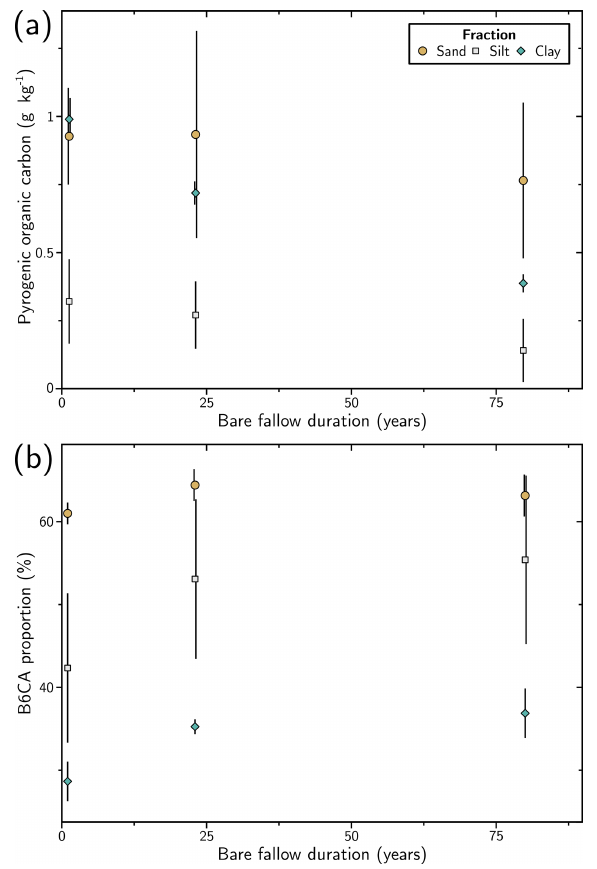
Figure 4. Evolution of selected results from benzene polycar- boxylic analyses with duration of the long-term bare-fallow exper- iment for the studied size fractions: (a) pyrogenic organic carbon content; (b) proportion of benzene hexacarboxylic acid (B6CA) molecular marker. The error bars correspond to 2 standard devia- tions calculated from the four plot replicates.